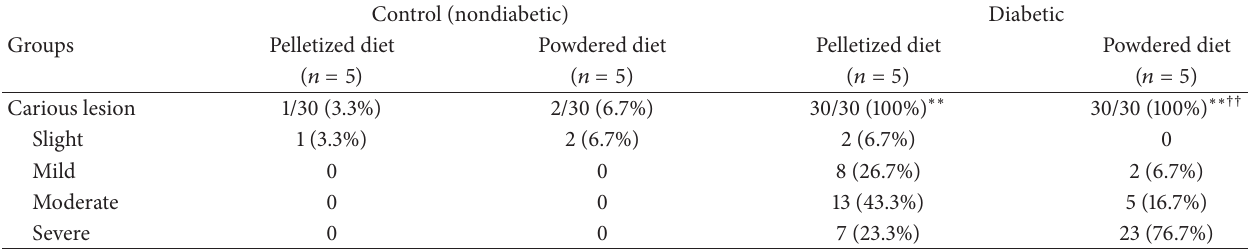
Table 2: Histopathological carious lesions in the mandibular molars of diabetic rats fed on a pelletized or powdered diet.